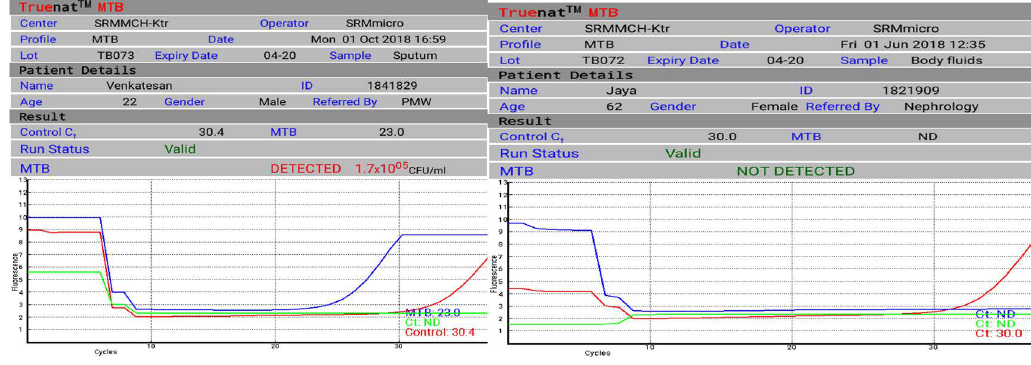
Fig. 3,4. Positive and negative RT PCR